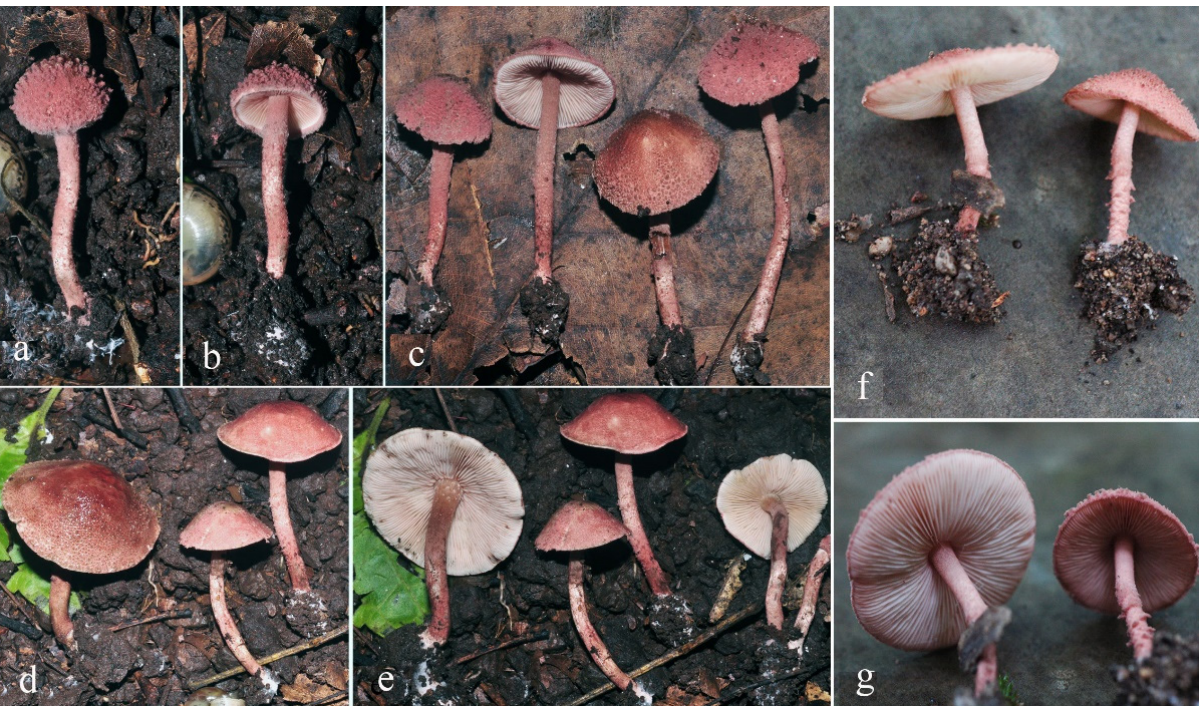
Figure 6 . Cystolepiota rhodella . ( a – c ) = MFLU22-0019, ( d , e ) = HNL501799 (holotype), ( f , g ) = (MFLU09-0050).